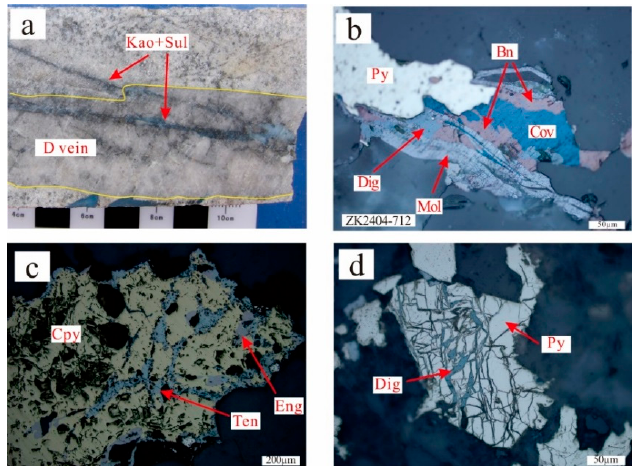
Figure 4. Textures of epithermal sulfides overprinting porphyry sulfides. ( a ) Kaolinite-sulfide veinlets cross-cut quartz-pyrite veins, ( b ) later covellite and digenite replacing borinite and ( c ) tennantite and engargite replacing chalcopyrite, ( d ) pyrite fractures filled with digenite. Bn: